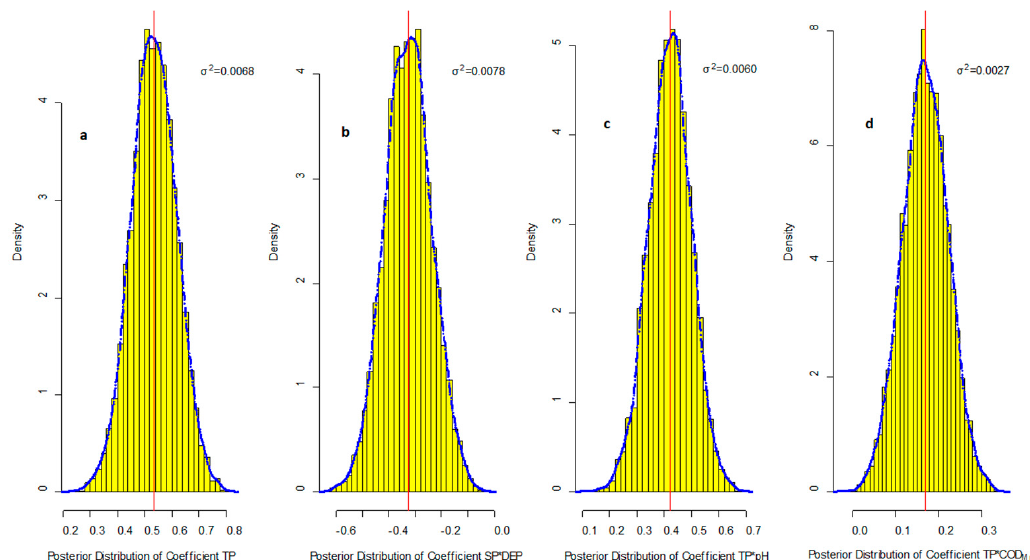
Figure 3. The posterior distribution of coefficients for S(-II). The blue dotted line is the kernel density estimation for the coefficients, the solid red line is the posterior mean value of coefficients, σ 2 is the posterior variance of coefficients, and the yellow bars are histogram of density of posterior coefficients; ( a ) TP coefficient; ( b ) TP × water depth (DEP) coefficient; ( c ) TP × pH coefficient; (d) TP × O 2 demand (CODMn) coefficient